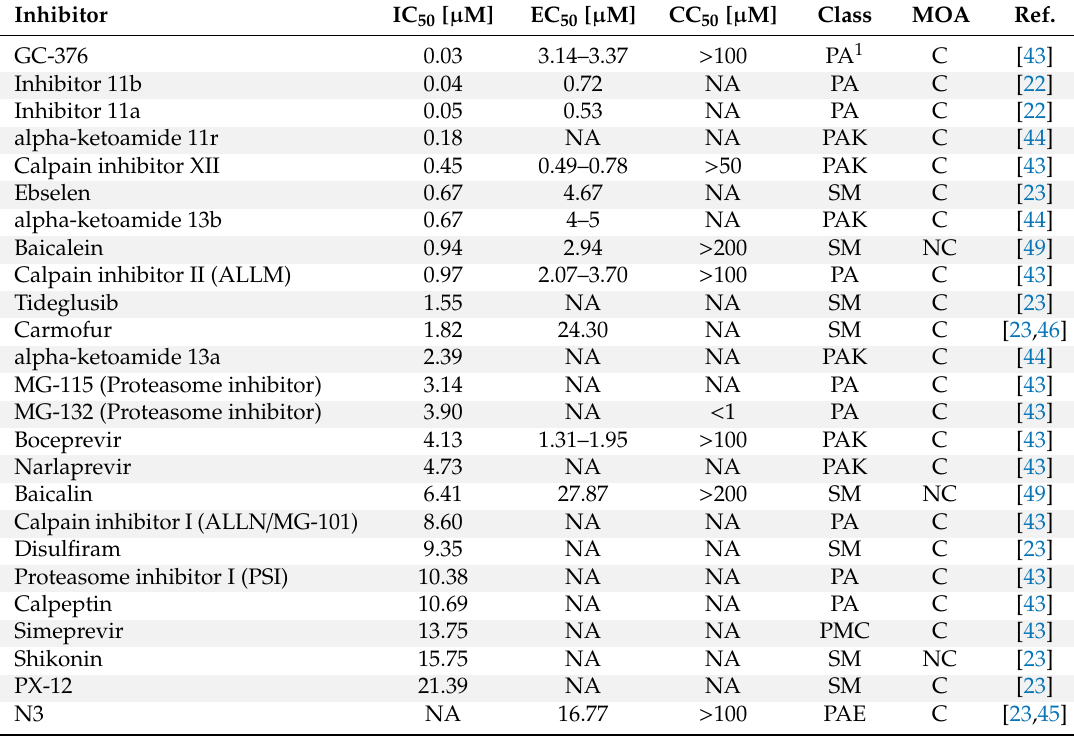
Figure 6. SARS-CoV-2 Mpro small molecule covalent inhibitors. ( A ) Surface representation of one protomer from the crystal structure of SARS-CoV-2 Mpro with the carmofur fatty acid moiety (green) bound to the active site. Inset: close-up view of the inhibitor-bound active site, with residues forming the catalytic dyad indicated in turquoise (His 41 ) or orange (Cys 145 ) and hydrogen bonds indicated by dashed black lines. ( B ) Stick representation of the fatty acid (FA) moiety of carmofur (green) covalently bound to the catalytic cysteine residue (orange). In addition, the 5-fluorouracil (5-FU) moiety released during binding of carmofur to the active site is also shown. ( C ) Structure of di ff erent small molecule covalent SARS-CoV-2 Mpro inhibitors. For pharmacological properties, see Table 2. Table 2. Inhibitors of SARS-CoV-2